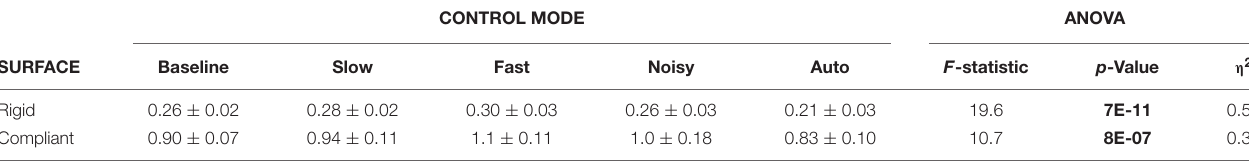
TABLE 4A | Mean control efficiency ( sec 2 /N 2 ) across control modes on rigid and compliant surfaces.